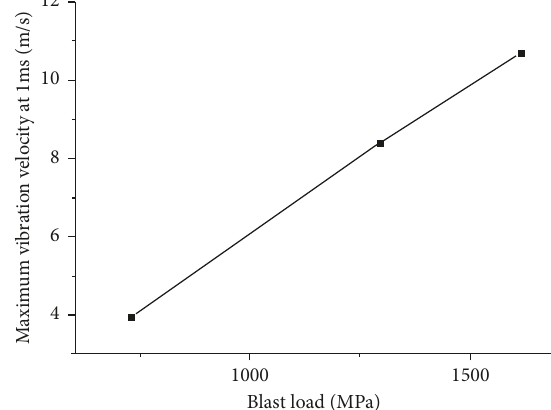
Figure 11: Maximum vibration velocity at 1 ms under different blasting